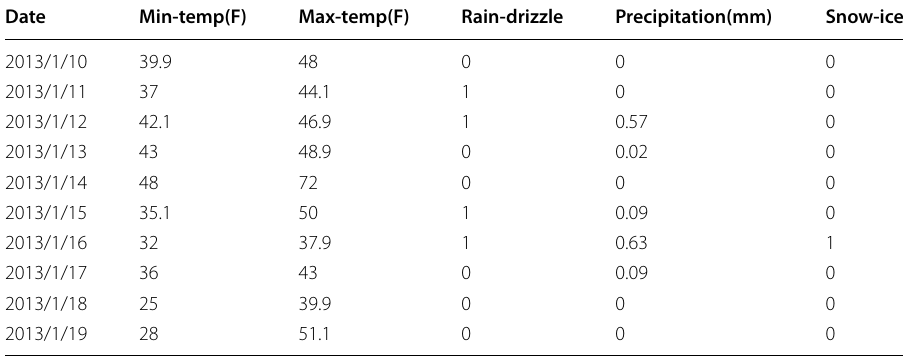
Table 2 Part of the weather data for 10 consecutive